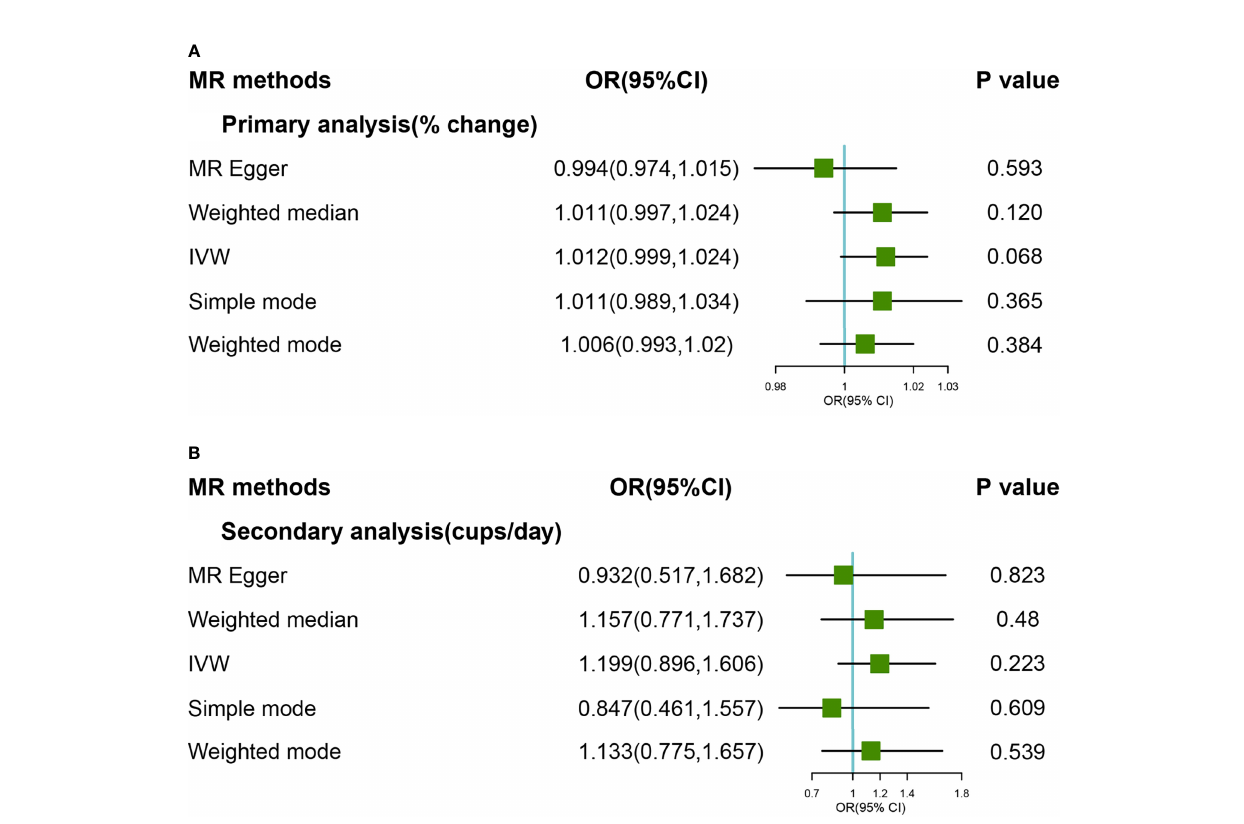
FIGURE 3 | Forest plot of MR study using (A) primary genetic instruments with hip OA. MR, Mendelian randomization; OR, odds ratio; CI, con fi dence interval; IVW, inverse variance weighted; OA, Osteoarthritis. Forest plot of MR study using (B) secondary genetic instruments with hip OA. MR, Mendelian randomization; OR, odds ratio; CI, con fi dence interval; IVW, inverse variance weighted; OA,